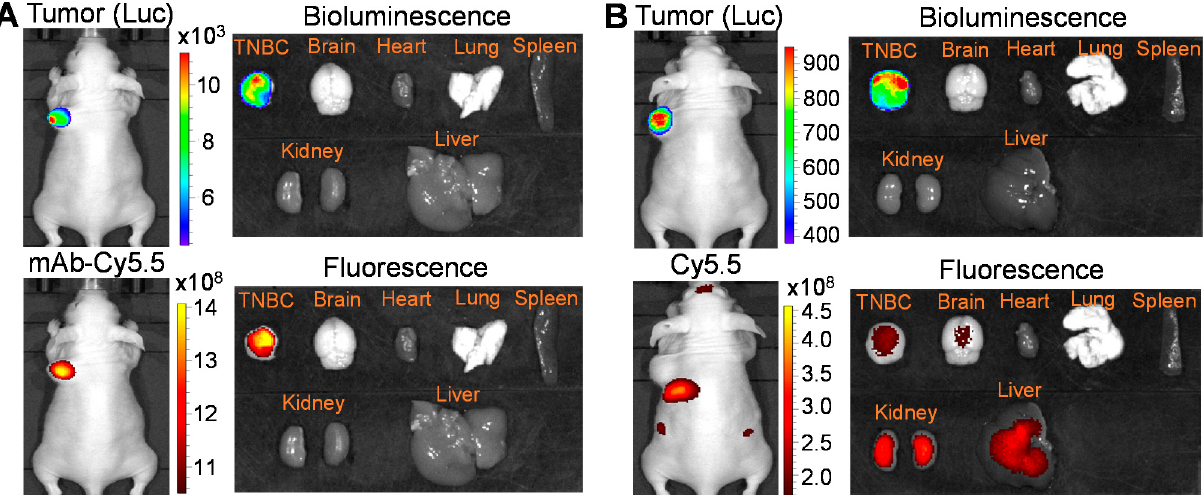
Figure 4. In vivo evaluation of TNBC targeting by anti-CD47 mAb in xenograft mice. ( A ) Live-animal and ex vivo IVIS imaging to confirm TNBC-specific targeting of CD47 mAb-Cy5.5. The IVIS images were collected at 24 h post tail vein injection of fluorescent dye Cy5.5-labelled mAb. ( B ) IVIS imaging showing the non-specific distribution of Cy5.5 dye in multiple organs such as kidney, liver, and brain in addition to the tumor.